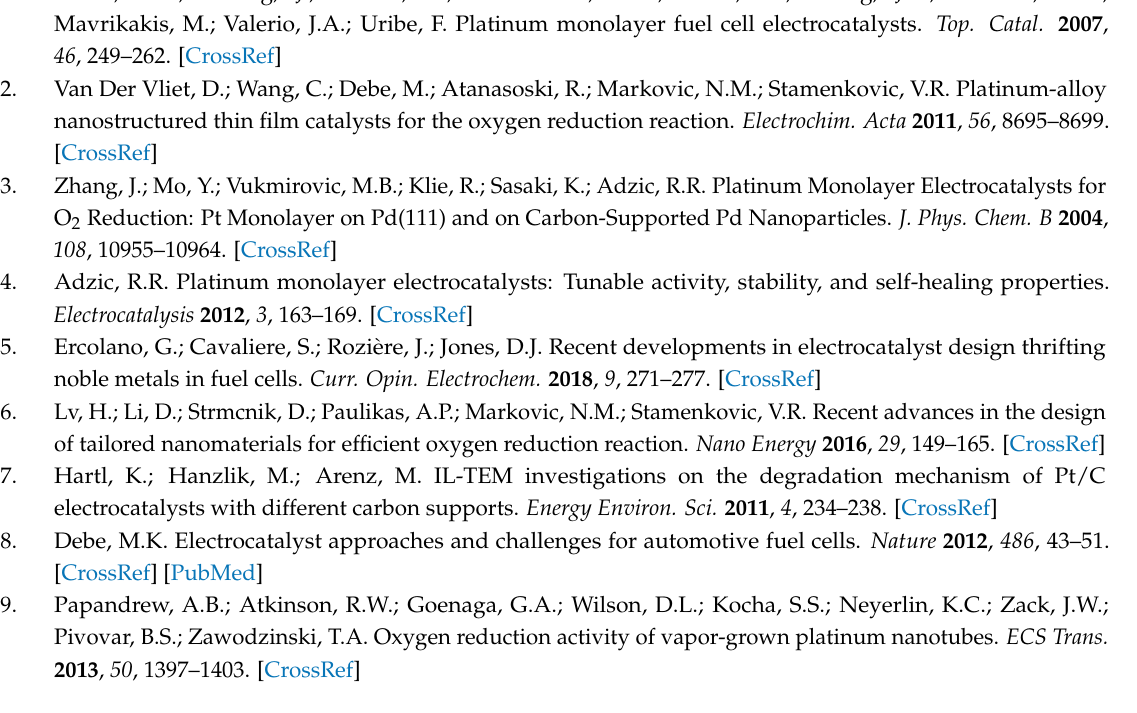
Figure S1: Cyclic voltammogram of the Au electrode in 0.1 M HClO4 at a scan rate of 100 mV/s, Figure S2: Linear sweep voltammetry after tellurium UPD deposition for various times of deposition at 0.35 V vs. RHE. (a) peak A1; (b) peak A2, Figure S3: Cyclic voltammogram of the Pt electrode in 0.1 M HClO4 at a scan rate of 100 mV/s, Figure S4: Cyclic voltammogram of the Pt electrode in 0.1 M HClO4 at a scan rate of 100 mV/s, Figure S5: EDS spectra of (a) bare Au-coated glass slide and (b) Pt deposit on Au-coated glass slide. Red arrows indicate the expected position of Te peaks, showing the absence of the element in the